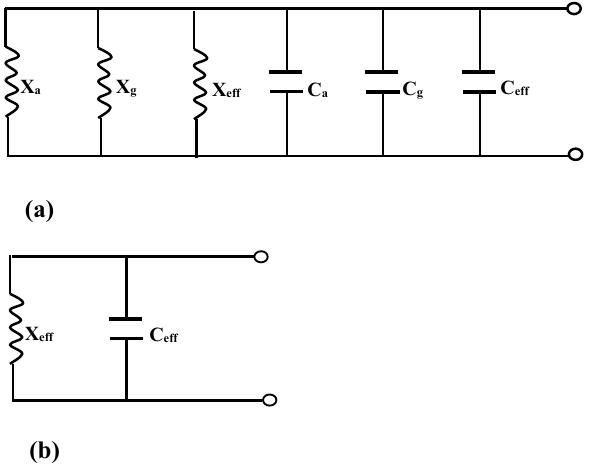
Figure 12. Equivalent circuit diagram of Ag/PAD/Ag sensor ( a ) detailed ( b ) effective.